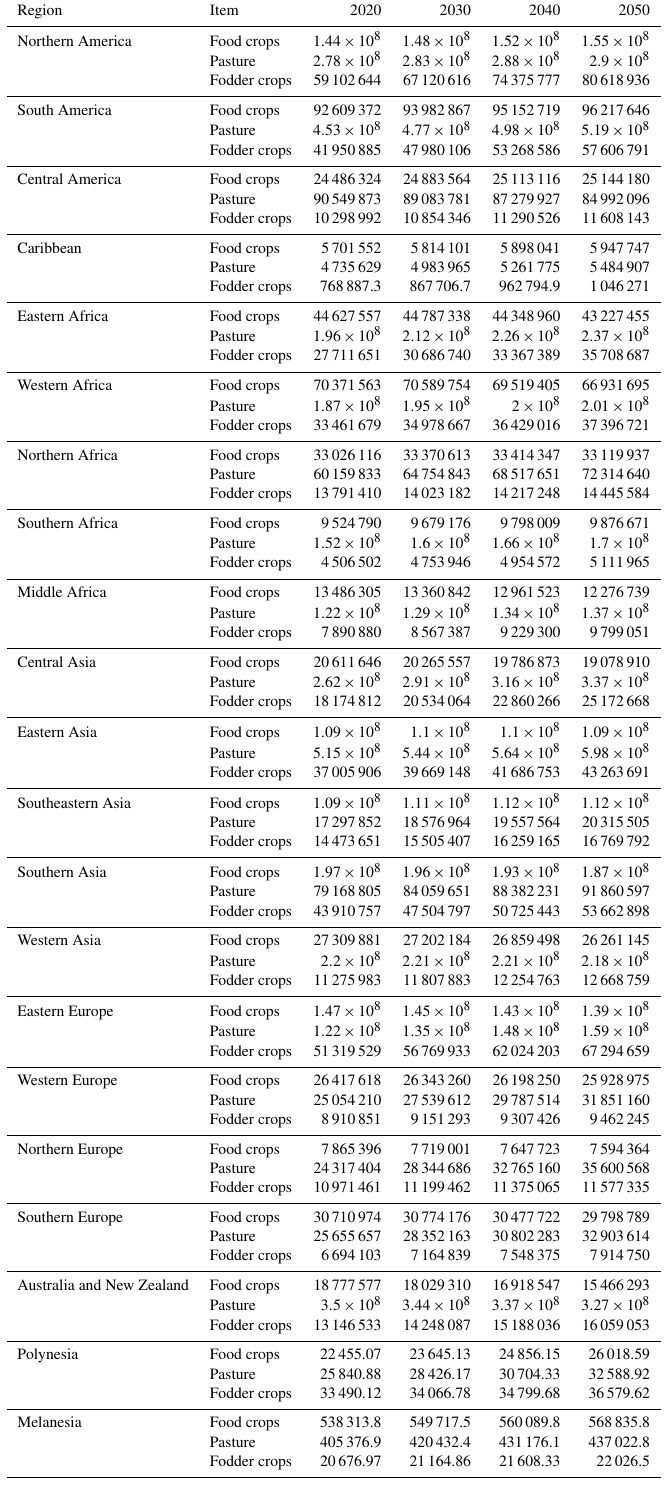
Table E1. Table of aggregated land use areas at a regional level in the C-LLAMA anchor scenario. Values are in hectares. Region